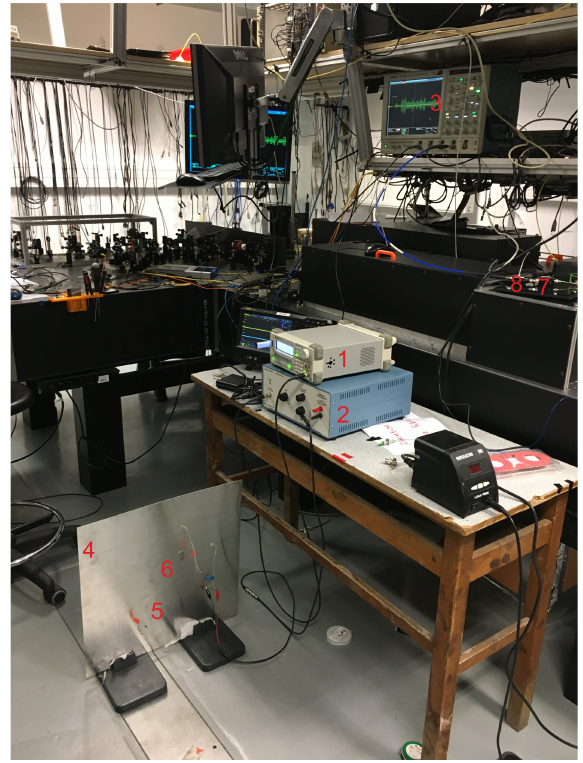
Figure 7. Experimental set-up. 1—wave generator; 2—voltage amplifier; 3— Oscilloscope; 4—plate; 5—PZT; 6—FBG; 7—photodetector;